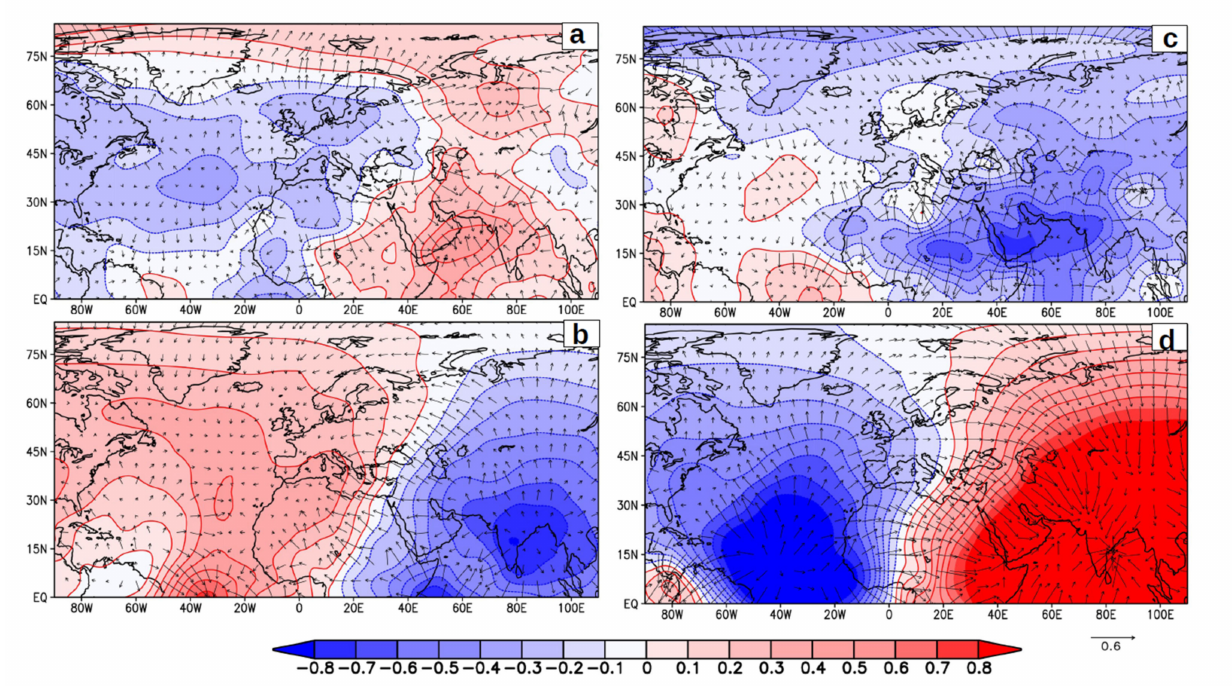
Figure 7. Composites of JJAS Velocity potential anomalies (1 × 10 6 m 2 s − 1 , shading) and divergent wind anomalies (vectors, ms − 1 ) for strong (left panel, ( a , b ) and weak (right panel, ( c , d )) ISM years. Upper panel corresponds to 1000 hPa and lower level corresponds to 200 hPa